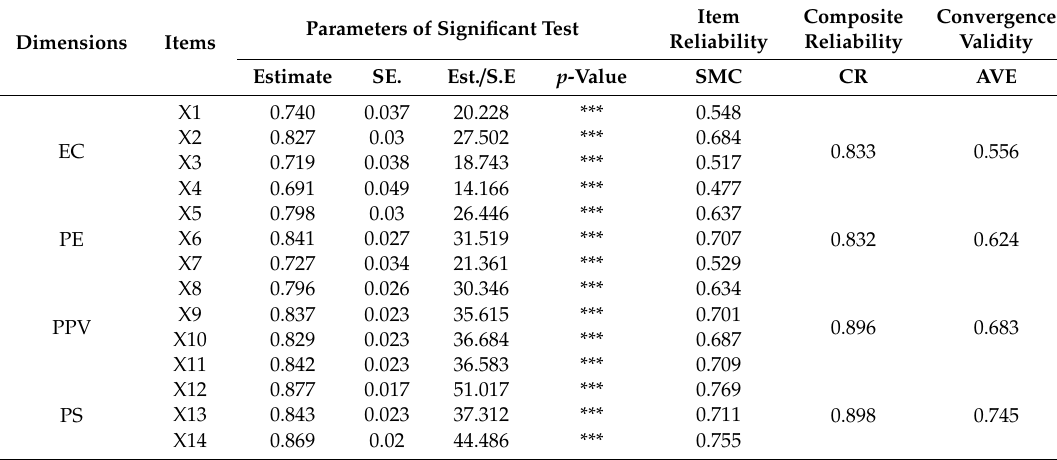
Table 3. Validity and reliability for constructs.